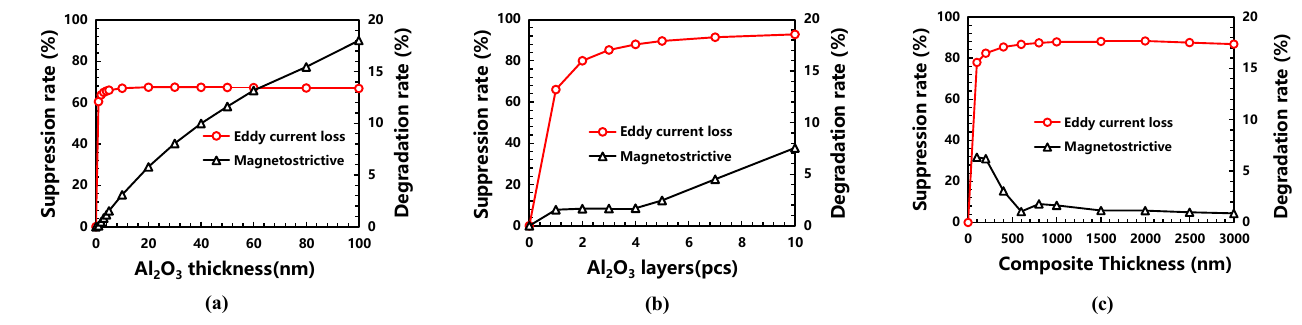
Figure 3. Suppression of the eddy current loss and degradation of magnetostriction by inserting an alumina insulation layer into the FeGaB: ( a ) the thickness effect of the single-layer alumina; ( b ) the layer number effect of the inserted 5 nm alumina; ( c ) the thickness effect of the magnetic composite.